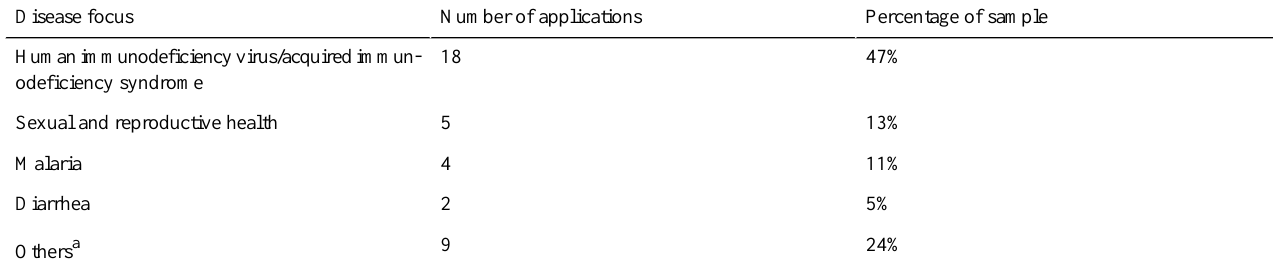
Table 3. Short message service (SMS) for disease prevention: disease focus of 34